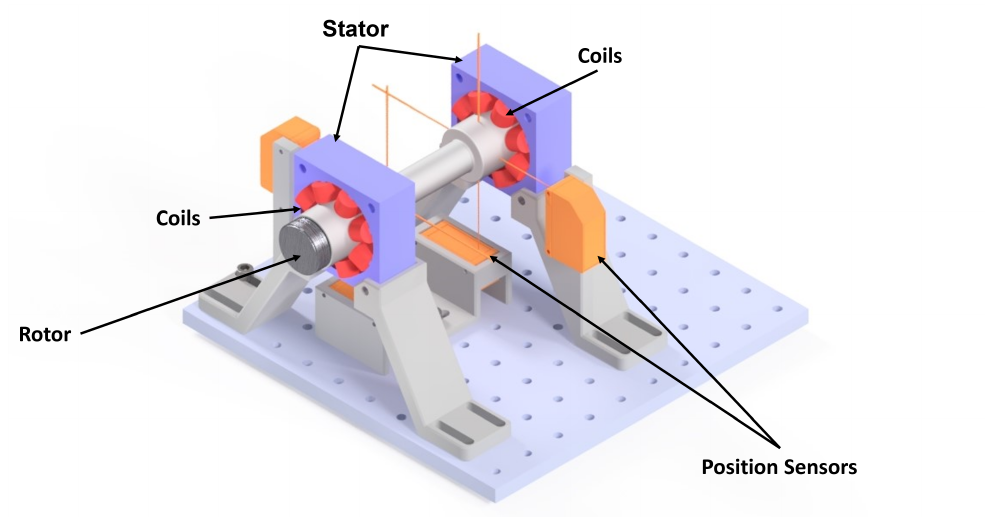
Figure 7. Assembly of the test bench with stator (blue), coils (red), position sensors (orange) and rotor (grey) [12].